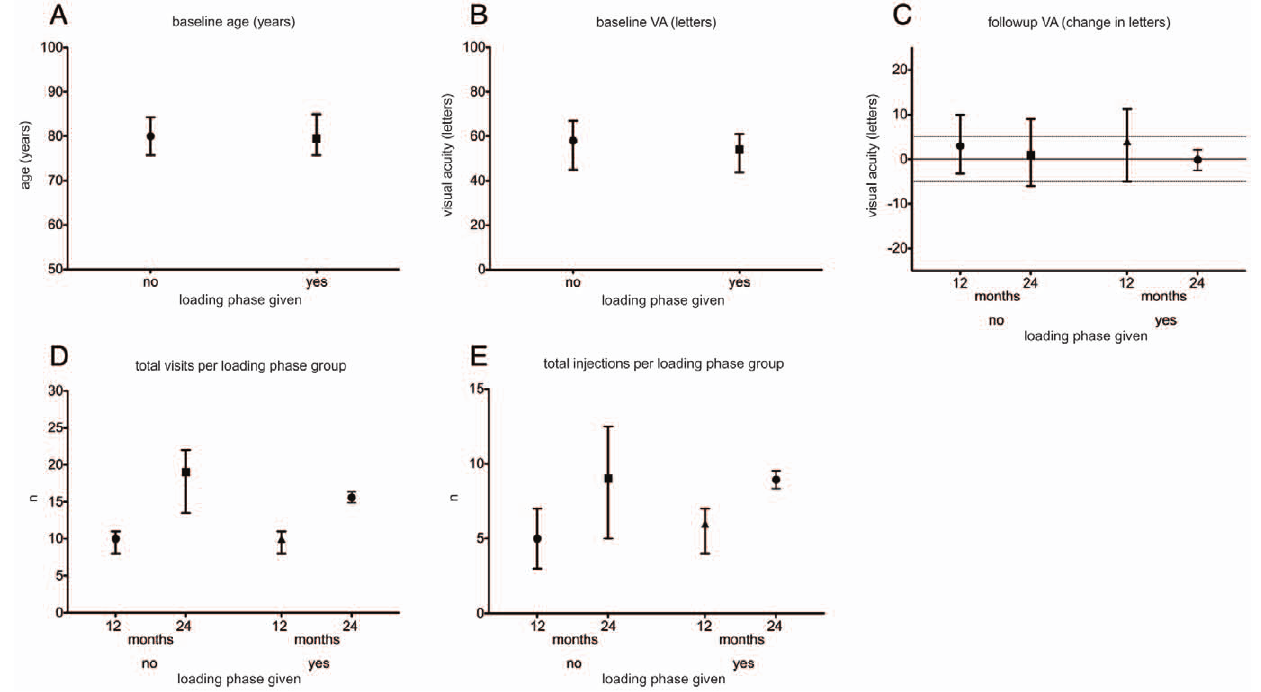
Figure 2. Overview of the loading phase groups. Values are displayed for age at baseline (A), visual acuity at baseline (B), VA at 12 and 24 months (C), number of visits in 12 and 24 months (D), total injections in 12 and 24 months (E) and distribution of CFH genotypes (F) in the loading phase groups. Symbols show the median while whiskers indicate the interquartile range. No statistically significant differences are found.